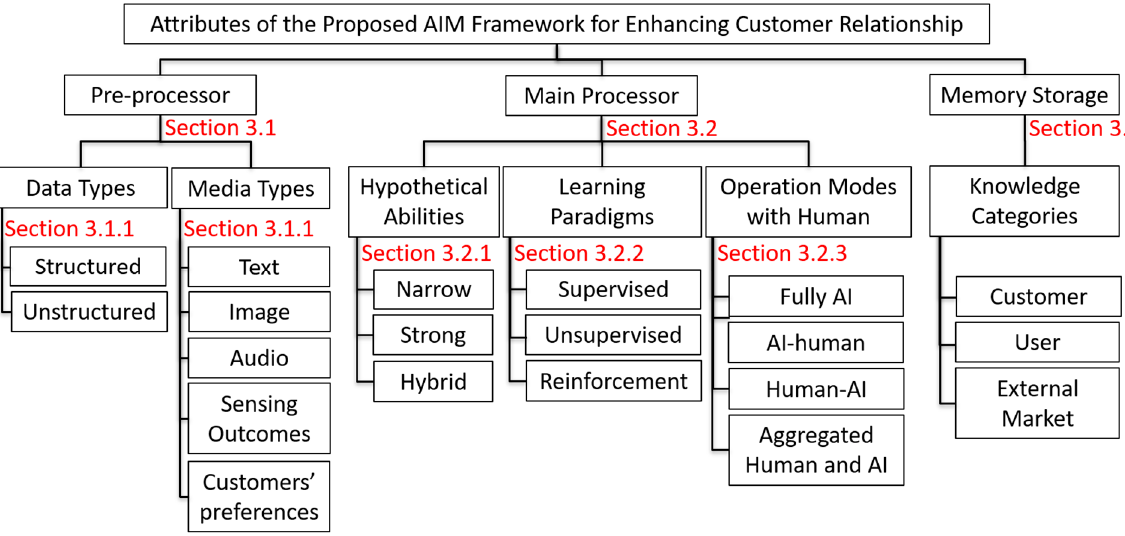
Figure 2. The attributes of the AIM framework for enhancing customer relationship.